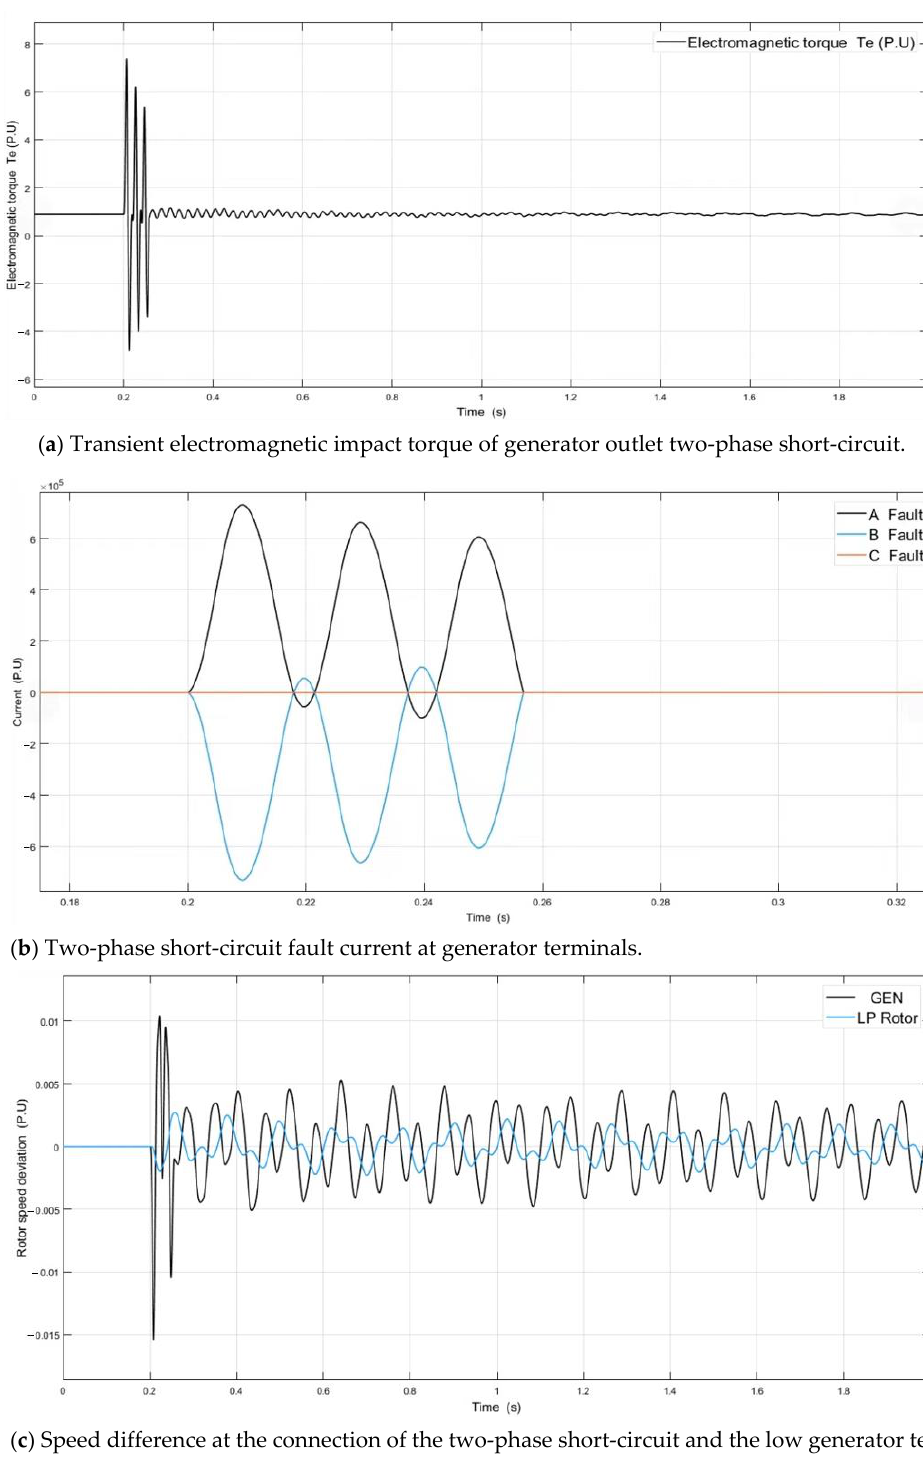
Figure 6. Characteristic curve of generator terminal’s two-phase short-circuit fault.